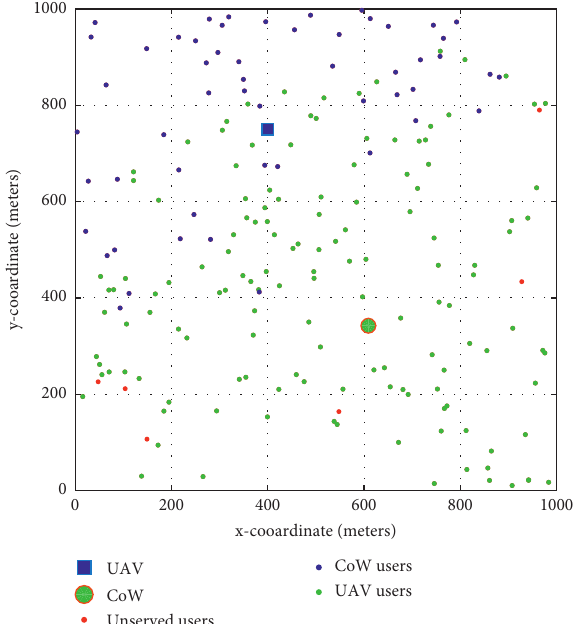
Figure 6: Deployment of the CoW and UAV using ES algorithm when the priority is given to the CoW at the beginning.